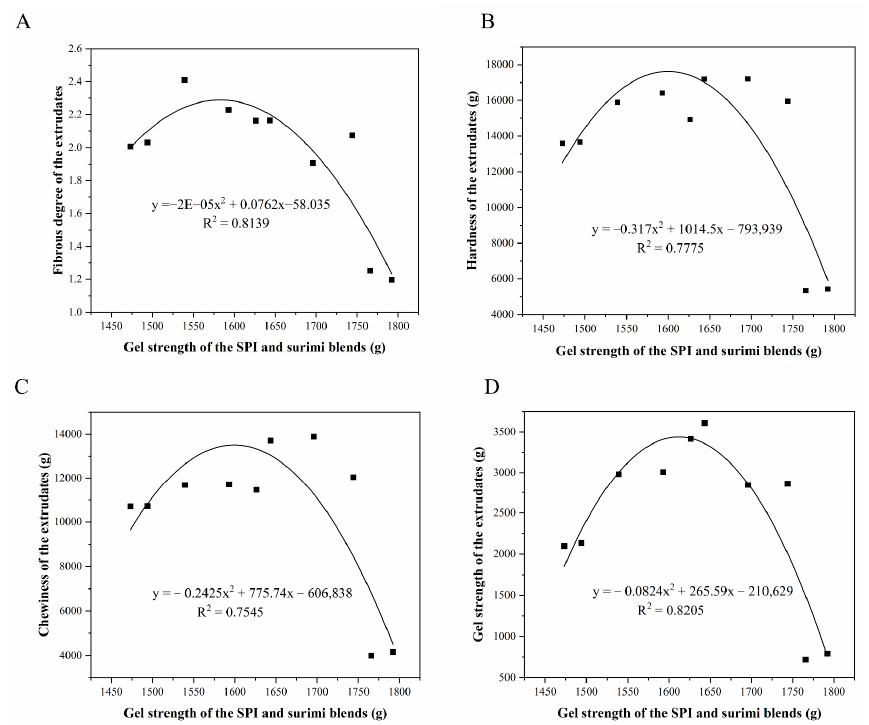
Figure 6. Relationships between the gel strength of the SPI and surimi blends and the fibrous degree ( A ), hardness ( B ), chewiness ( C ) and gel strength ( D ) of the extrudates.